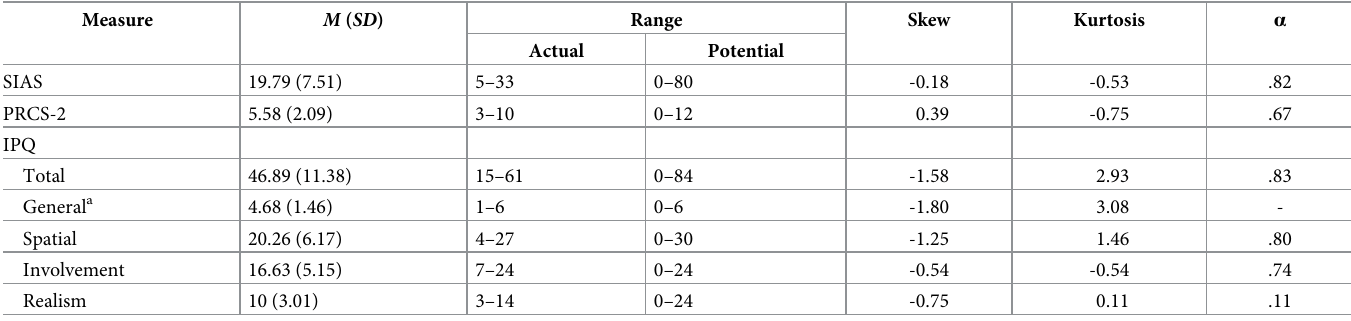
Table 1. Descriptive statistics for self-report measures (N = 19).